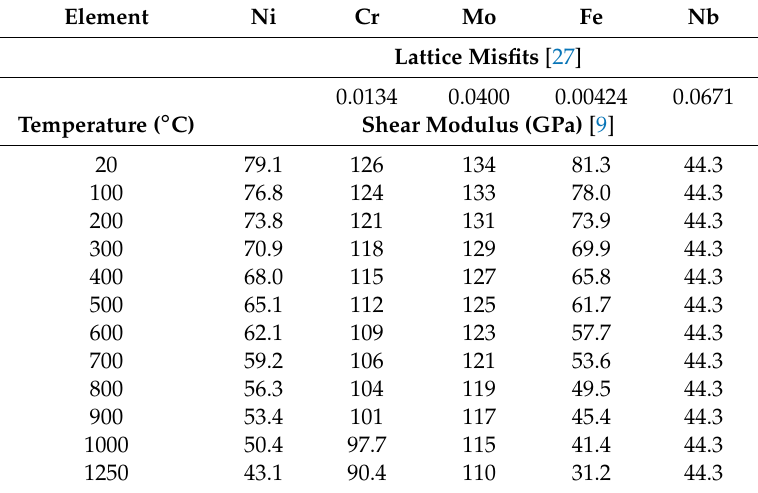
Table 2. Lattice misfits, δ , and temperature dependent shear modulus (GPa) for alloy 625 and alloy 718. Element